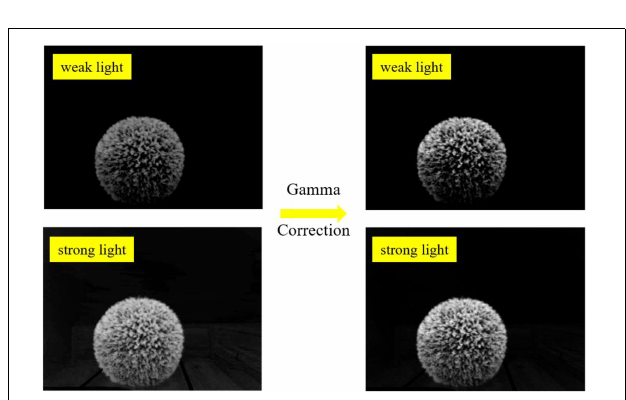
FIGURE 8 | The gamma transform graph at different γ values.